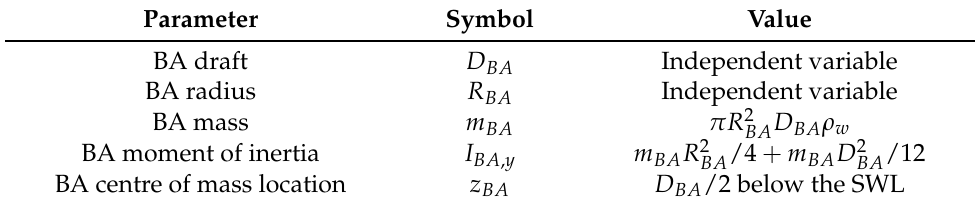
Table 2. BA design parameters.